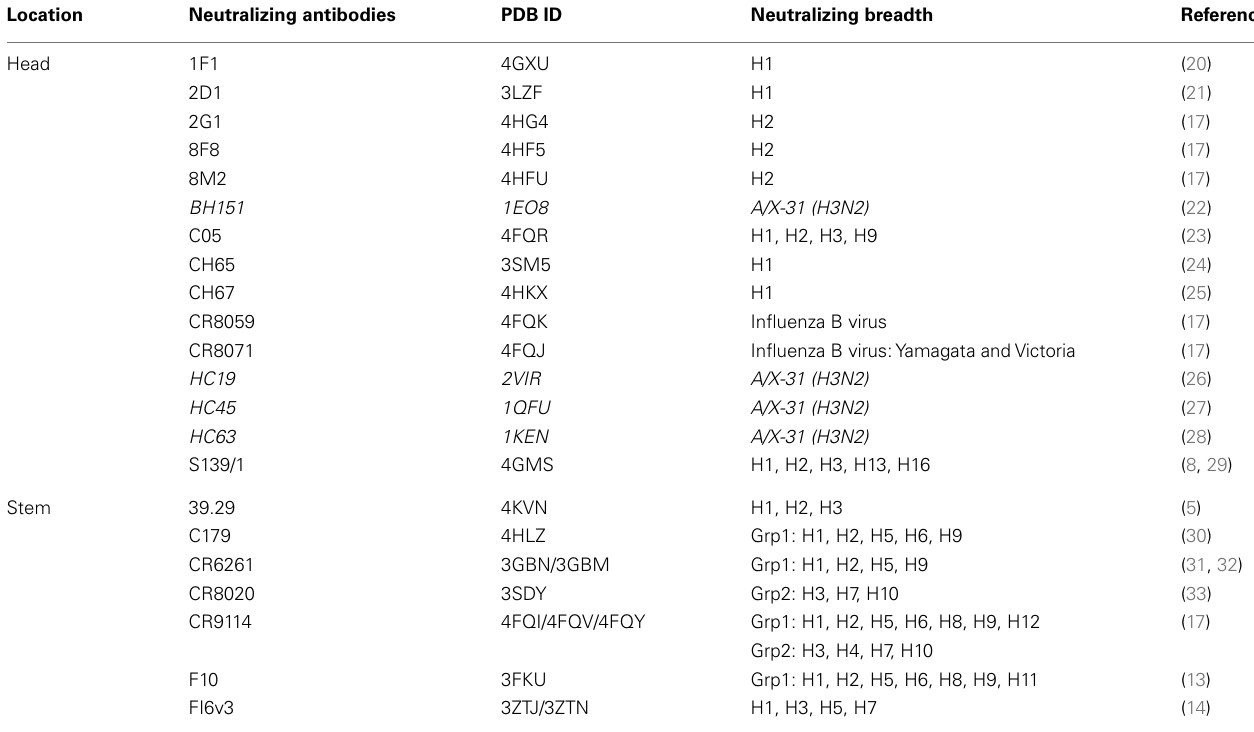
Table 1 | Summary of well-characterized neutralizing antibodies against influenza virus .